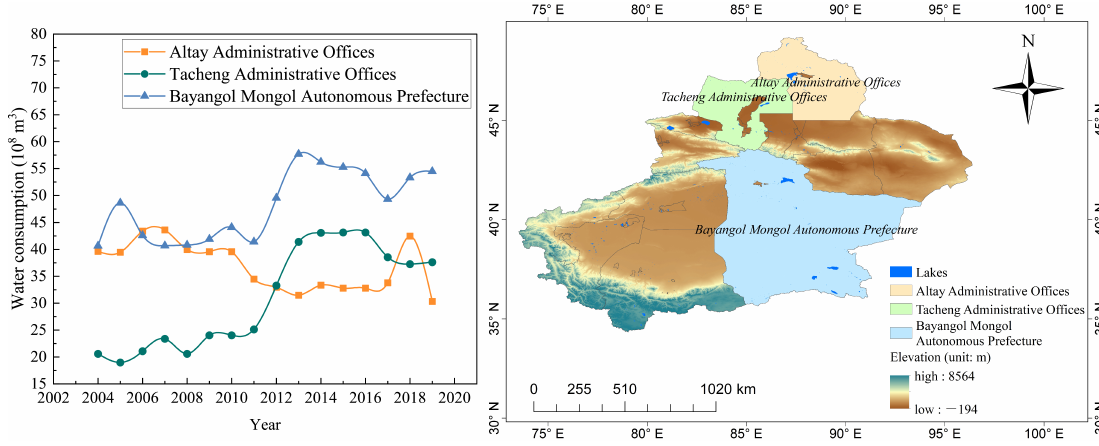
Figure 10. Water consumption of prefecture-level cities where six lakes are